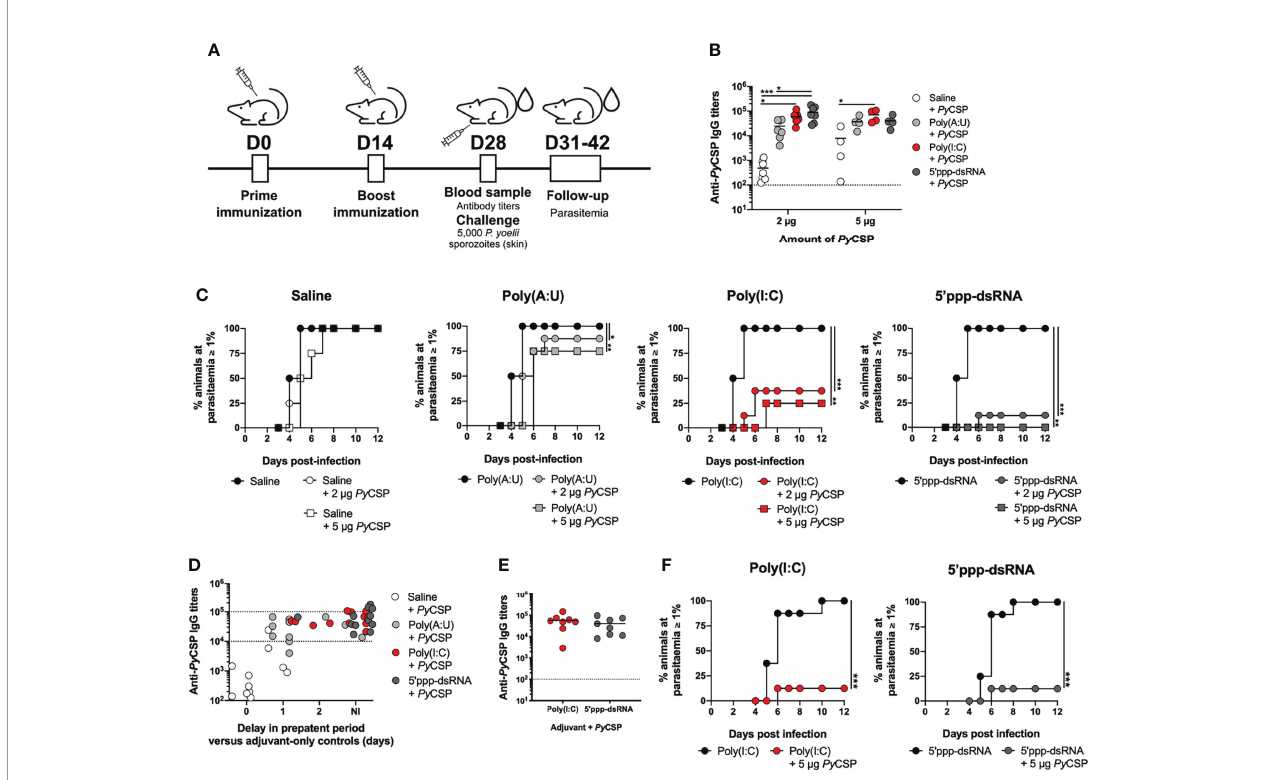
FIGURE 1 | Short-term protection conferred by immunization with Py CSP in combination with different adjuvants. (A) Immunization and challenge conditions. (B-D) Protection to a skin challenge in control mice (n = 8, two independent experiments) and mice immunized with 2 µg (n = 8, two independent experiments) or 5 µg (n = 4, one experiment representative of three, B or one independent experiment, C) of Py CSP in saline or in combination with different adjuvants, 2 weeks post booster immunization. (B) Total anti- Py CSP IgG titers in the sera of immunized animals. Symbols represent individual values and black lines the mean of each group. Dotted line represents the minimal detectable titer. (C) Incidence of blood stage infection in control and immunized animals. (D) Total anti- Py CSP IgG titers versus the delay in prepatent period, in days, in immunized mice. The interval for which sterile protection is independent of antibody titers is represented between dotted lines. (E, F) Protection to mosquito bite challenge in control mice (n = 8) and mice immunized with Py CSP in saline or in combination with poly(I:C) or 5 ’ ppp-dsRNA (n = 8, two independent experiments for each group), 2 weeks post booster immunization. (E) Total anti- Py CSP IgG titers in the sera of immunized animals. Symbols represent individual values and black lines the mean of each group. Dotted line represents the minimal detectable titers. (F) Incidence of blood stage infection in immunized and control animals. Statistical signi fi cance was determined using two-way ANOVA with Tukey ’ s multiple comparisons test (B) or using a two-tailed unpaired t -test (E). Survival curves were plotted using Kaplan-Meier plot and statistical signi fi cance was determined using the Log-Rank (Mantel-Cox) test (C and F). *p ≤ 0.05; **p ≤ 0.01; ***p ≤